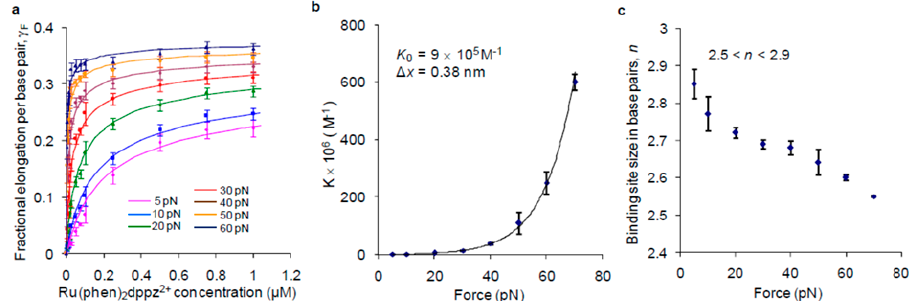
Figure 7. Dependence of [Ru(phen) 2 dppz] 2+ binding on force. ( a ) Titration curve fits using the McGhee–von Hippel model. ( b ) Binding constant dependence on force. ( c ) Binding site